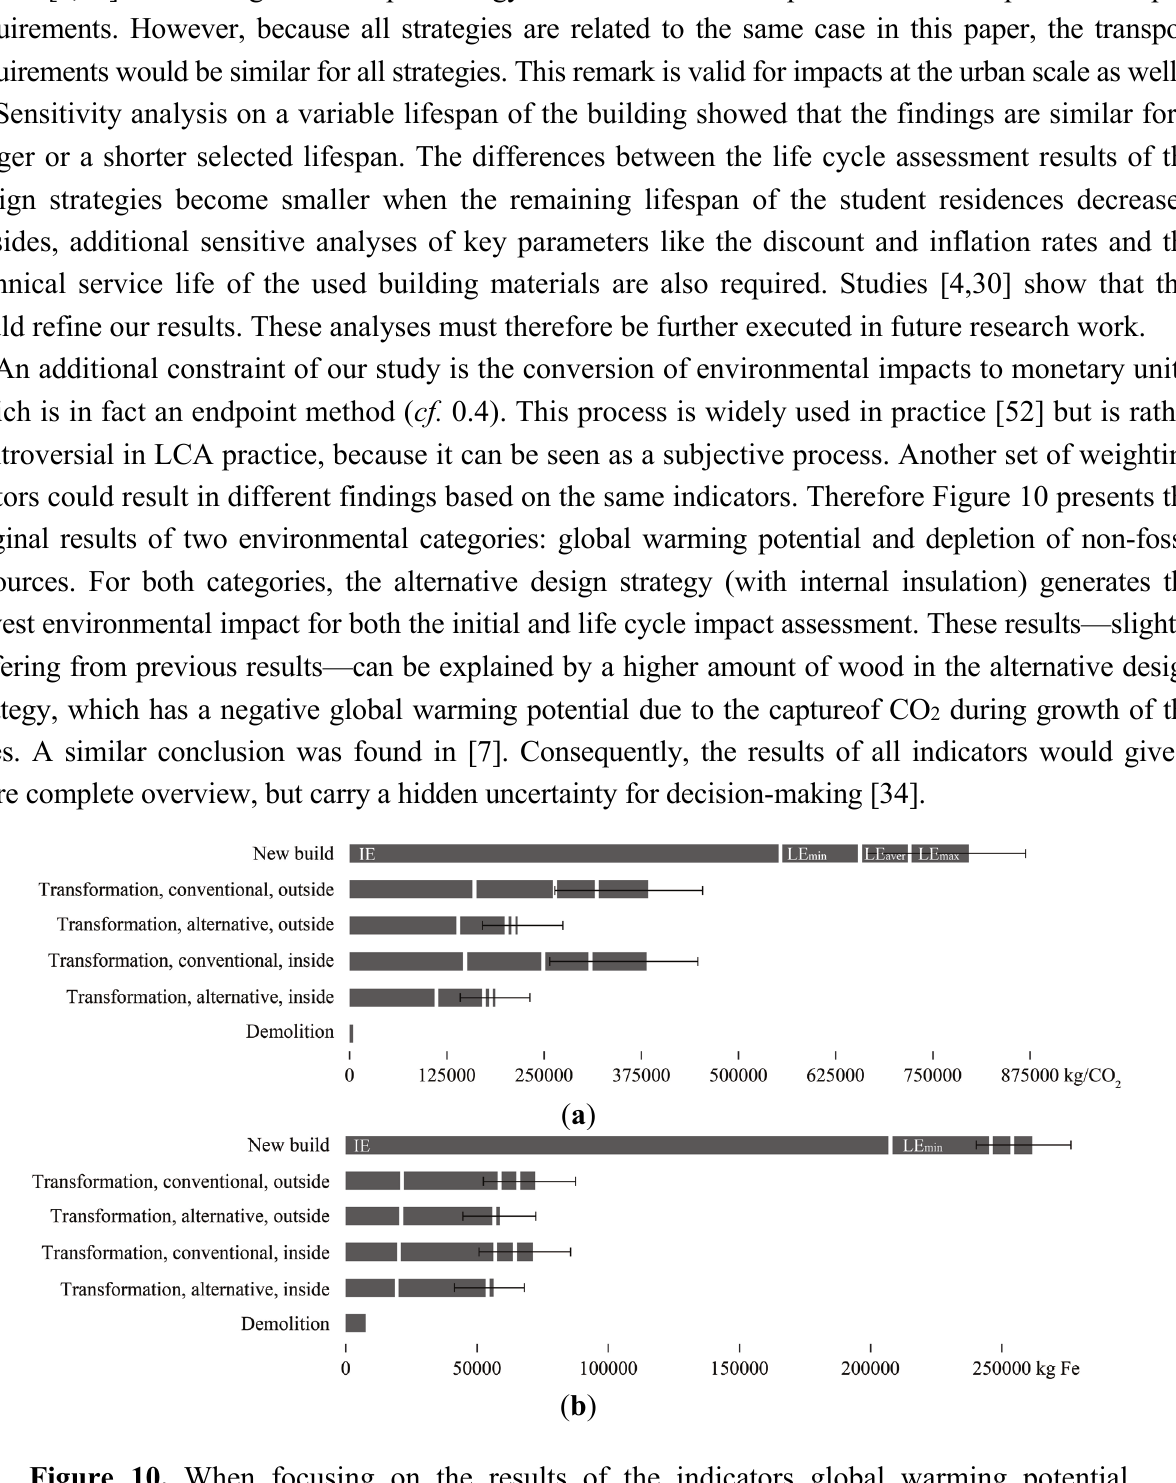
Figure 10. When focusing on the results of the indicators global warming potential (kg/CO 2 ) ( a ) and depletion of non-fossil resources ( b ), it can be concluded that the alternative design strategies have the lowest environmental impact. The error bars represent the results of the sensitivity analysis on a variable lifespan of the building (from 30 to 79